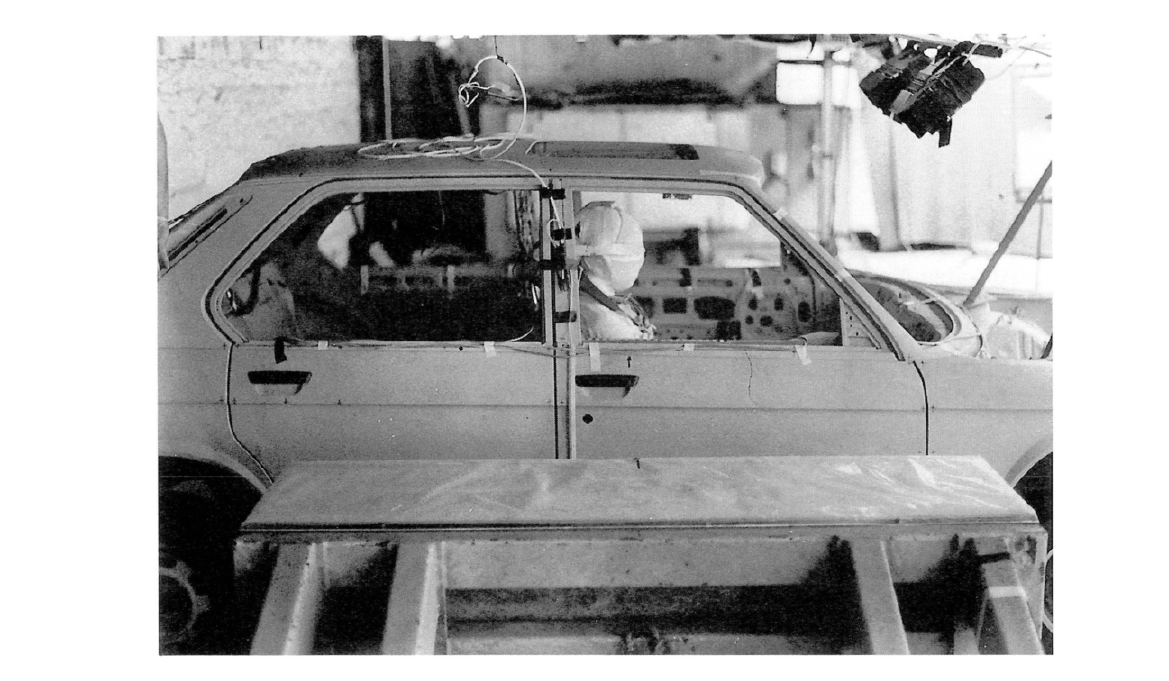
FIGURE 1 90° car/car lateral